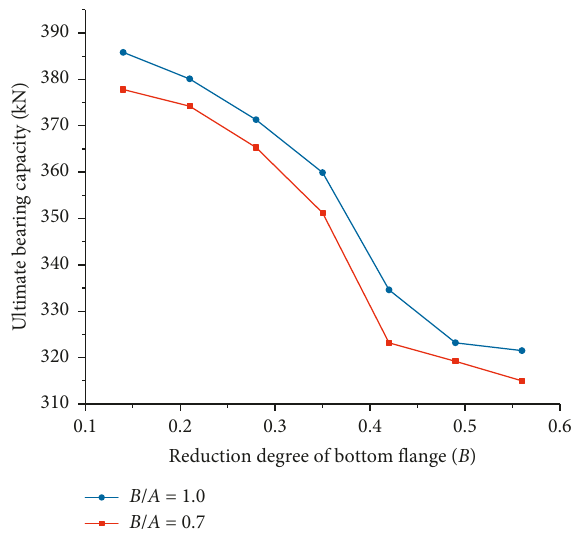
Figure 18: Effect of quantity of TC reinforcements.